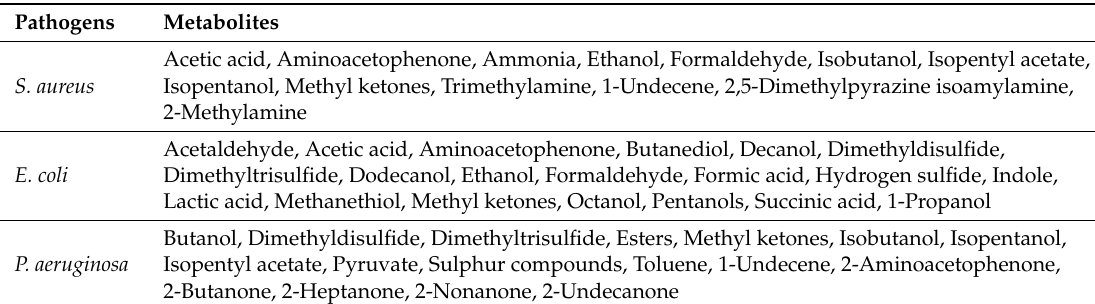
Table 2. Pathogens in wound infection and their